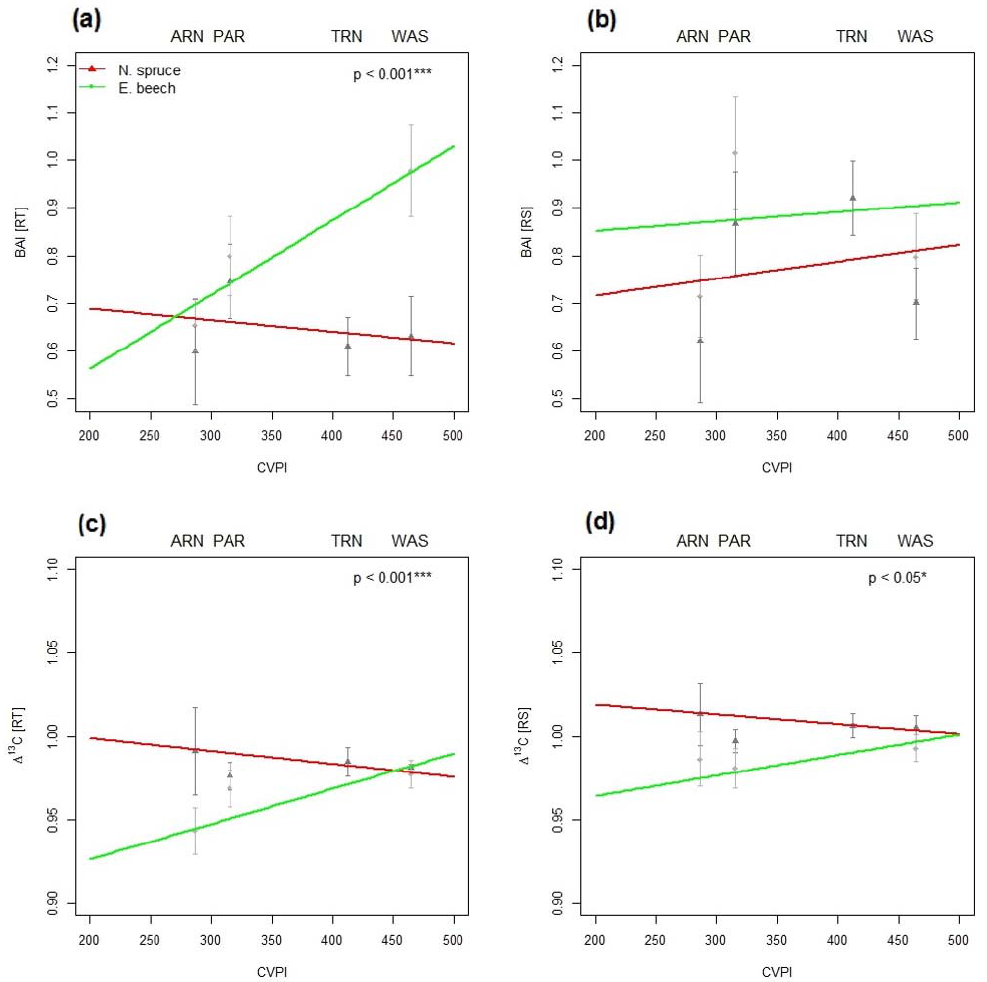
Figure 4. Linear mixed effect model of species and sites relative to the drought period 2003 for the BAI ( a , b ) and Δ 13 C ( c , d ) of beech (green line) and spruce (red line), represented by the CVPI, with means of RT and RS and confidence intervals (CI, 95%). The differences between species along the gradient are significant for BAI RT ( p < 0.001 ***), Δ 13 C RT ( p < 0.001 ***), and Δ 13 C RS ( p < 0.05 *).